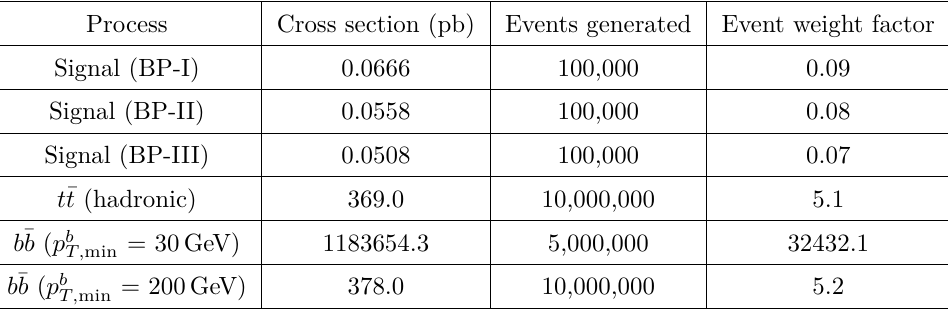
√ s = 13 TeV and L = 137 fb − 1